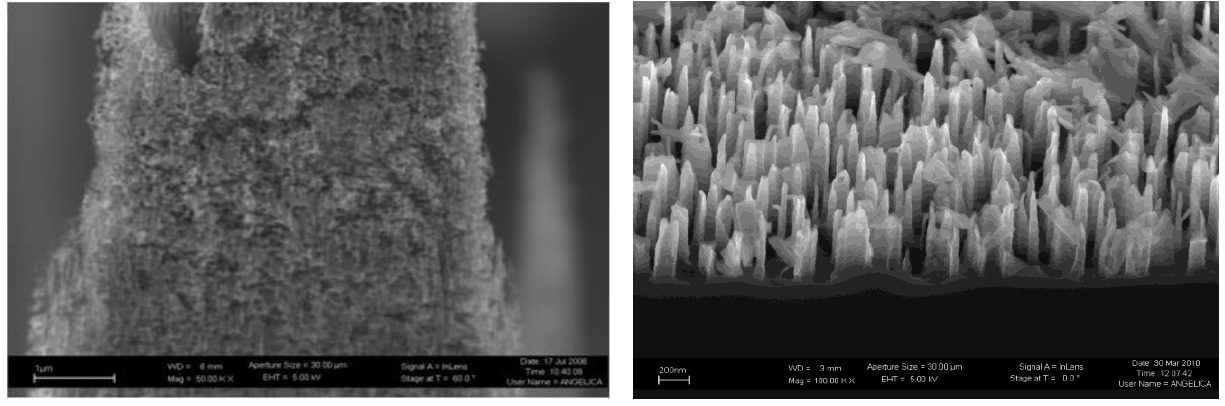
Figure 9. Nanostructured Si electrode obtained at Politecnico di Torino via the Black Silicon obtained by reactive ion etching (RIE) technology, described in